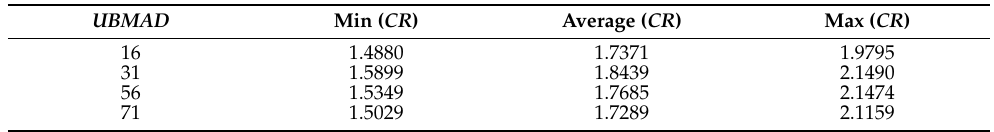
Table 7. Dependence of the minimum, maximum, and average values of CR on UBMAD for the case of DAT2 of depth